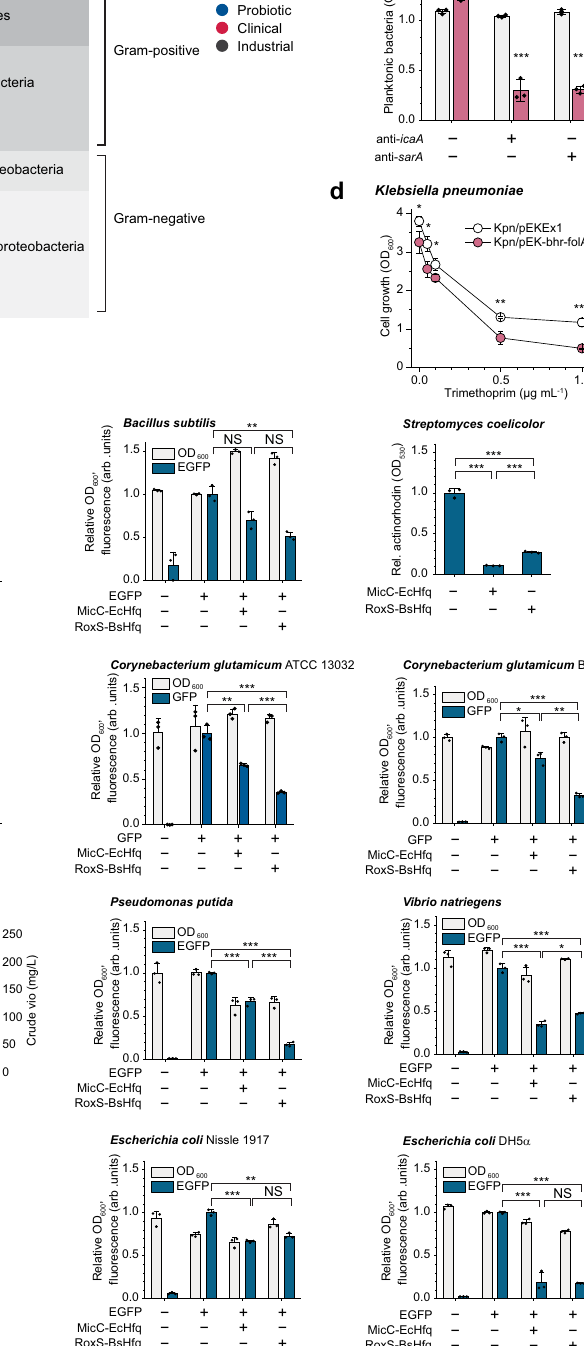
Student ’ s t -test. P -value thresholds were adjusted using Bonferroni correction ( P < α / m ). NS, not signi fi cant; arb. units, arbitrary units. c Quanti fi cation of bio fi lm formed by S. epidermidis with or without sRNA (anti- icaA or anti- sarA ), using the crystal violet assay. d Trimethoprim sensitivity of K. pneumoniae with or without anti- folA sRNA. Kpn, K. pneumoniae . ( c , d ) * P <0.05, ** P <0.01, *** P <0.005, deter- mined by two-tailed Student ’ s t -test. Error bars, mean±SD ( n =3 biologically independent samples; in panel d , n =4 biologically independent samples). Source data are provided as a Source Data fi